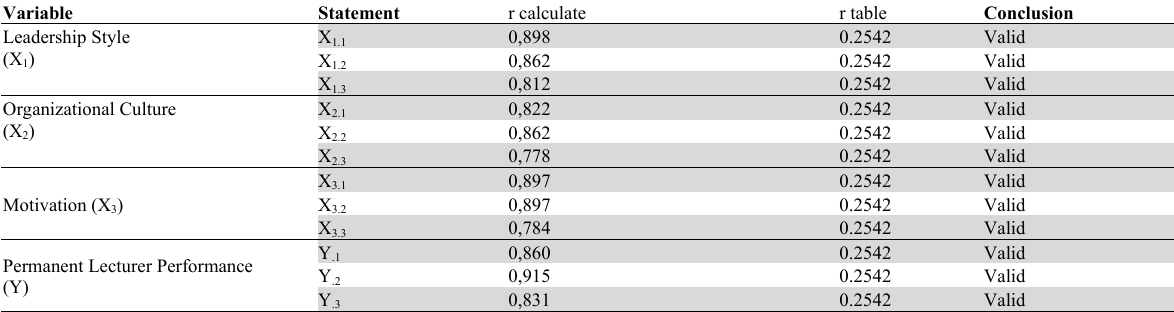
The summary of Pearson correlation test Variable Conclusion Leadership Style